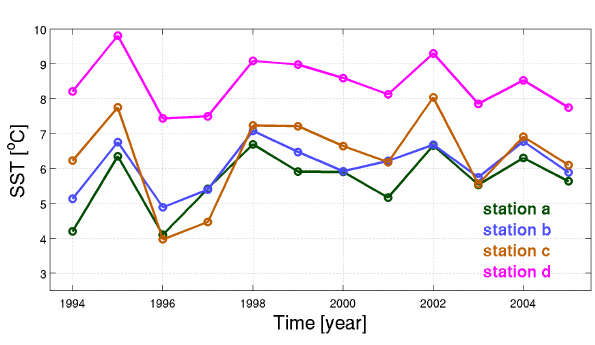
Figure 14. Sea surface temperature for the different years of particle distribution runs, averaged over February for each year. The colour of the lines represents the different stations as presented in Fig.